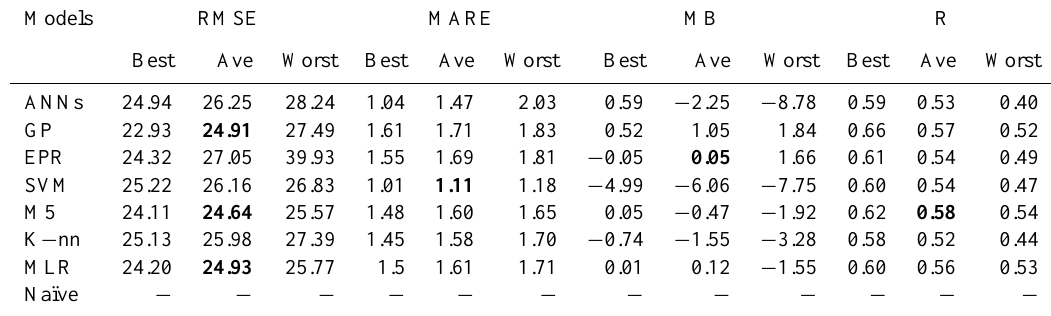
Table 15. Testing results of all models applied to the Rainfall-Runoff II. Models